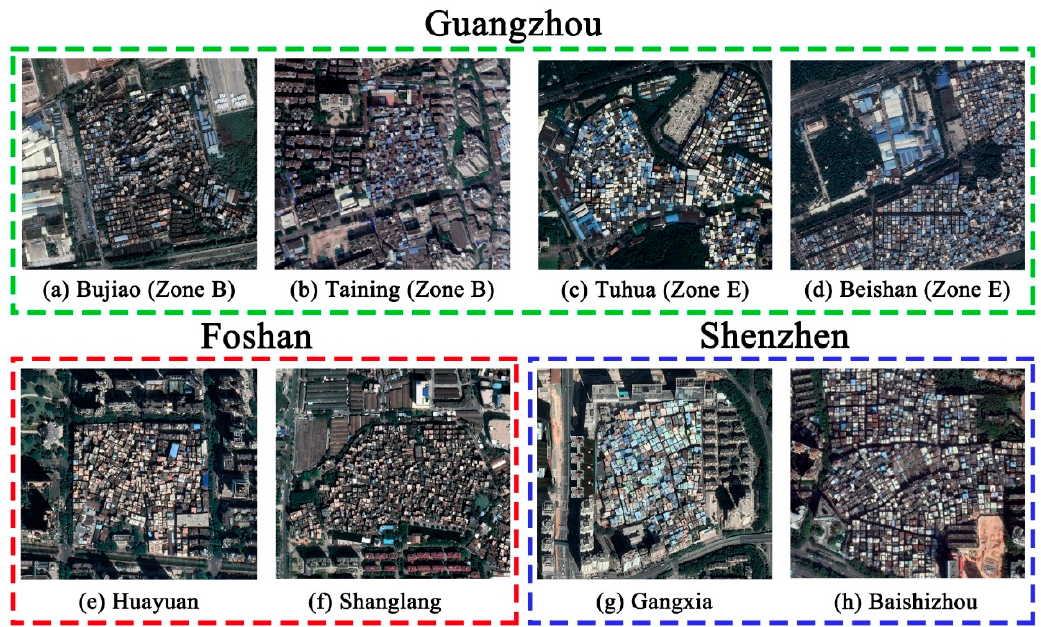
Figure 10. Urban villages in Guangzhou and neighboring cities (source: Google Earth).